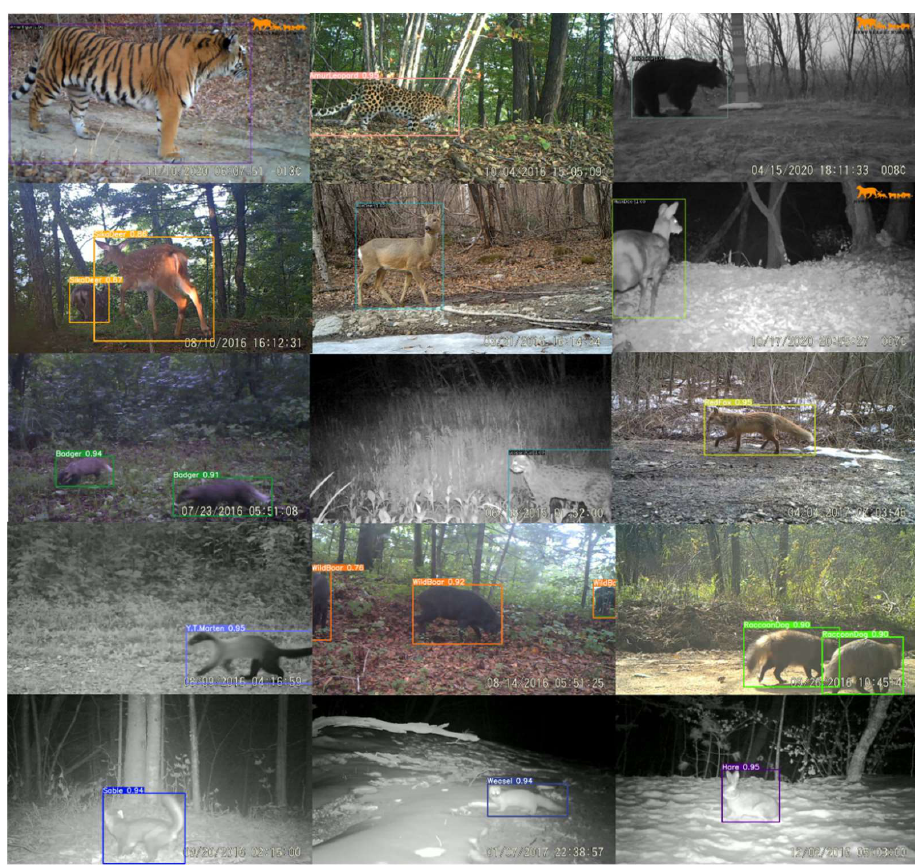
Figure 8. Examples of correct detection and